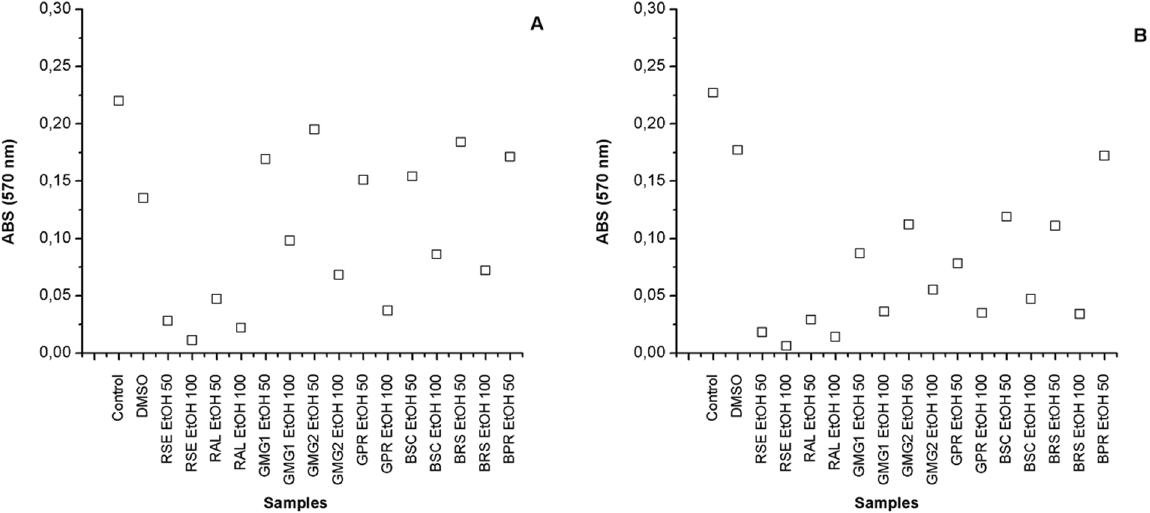
Fig 6. Activity of the EtOH extracts of different samples of Brazilian propolis on the cellular proliferation of the strain B16F10 (murine) after 24 (A) and 48 (B) hours of incubation on both concentrations tested (50 and 100 μ g/ml).